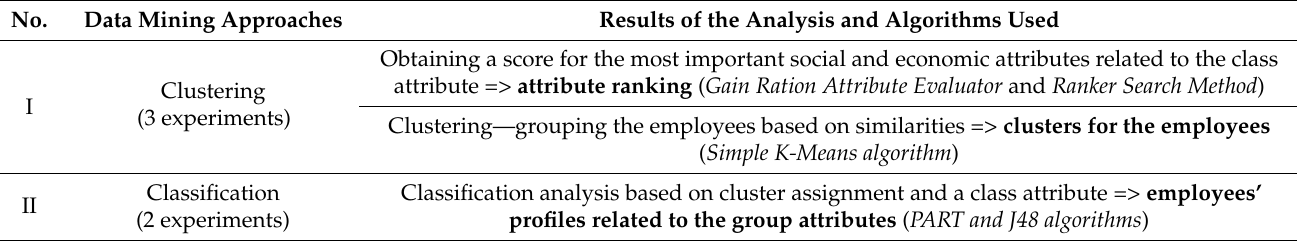
Table 2. Data mining